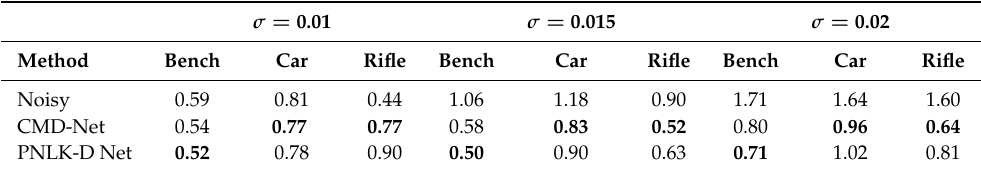
Table 3. Influence of PointNetLK on the denoising performance.